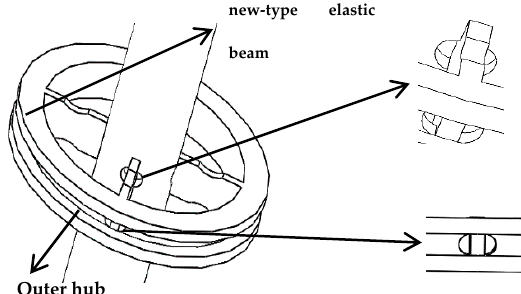
Figure 7. Small hole structure on the surface of outer hub and puncture needle cylinder.